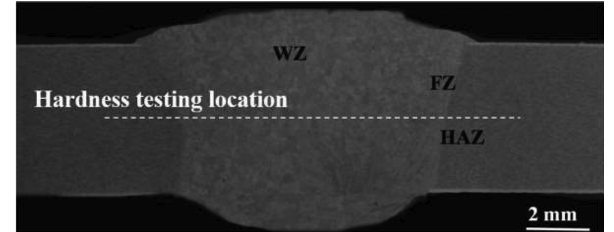
Figure 5: Cross-sectional overview of a DWMW A7N01P joint